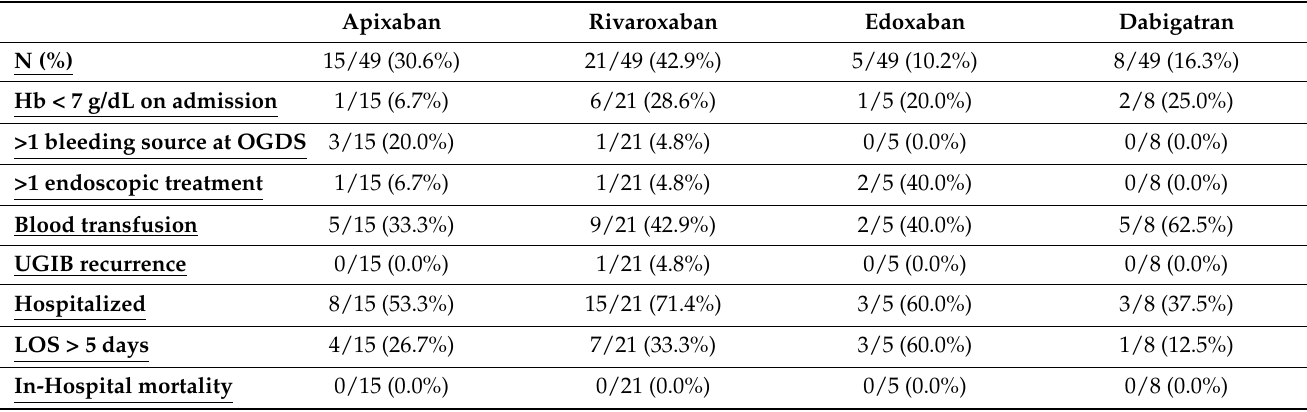
Table 3. Descriptive table on DOAC subgroup. Severity of anaemia, upper GI endoscopy, blood transfusion, UGIB recurrence, management setting, length of stay, in-hospital